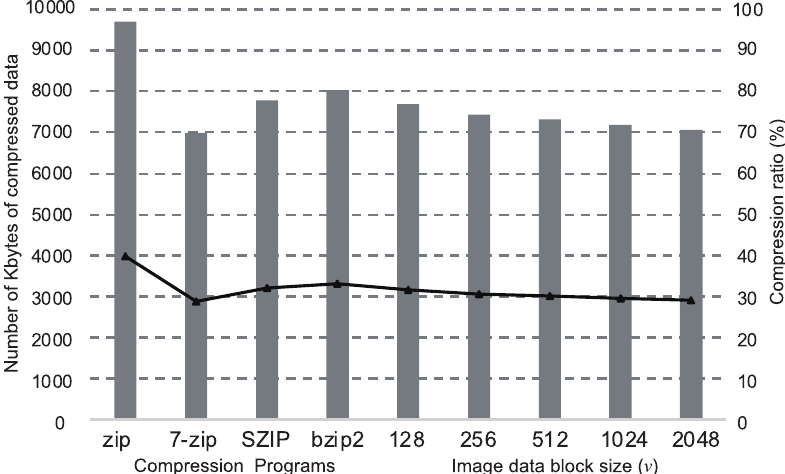
Figure 7. Comparisons of compression ratios with/without the DNN inference in the case of